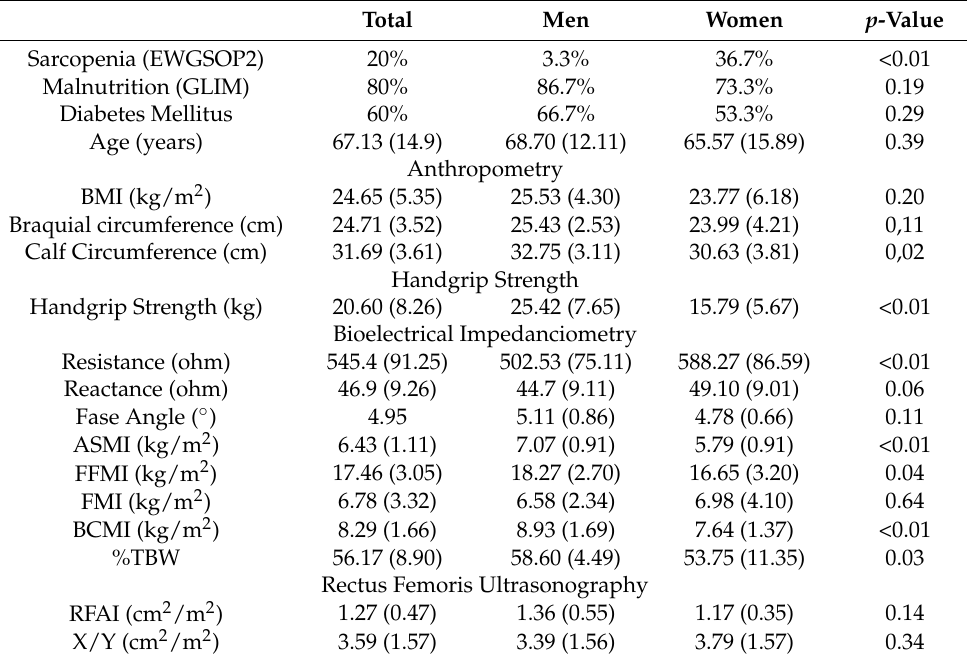
Table 2. Differences in the Morphofunctional Assessment at the beginning according to sex.